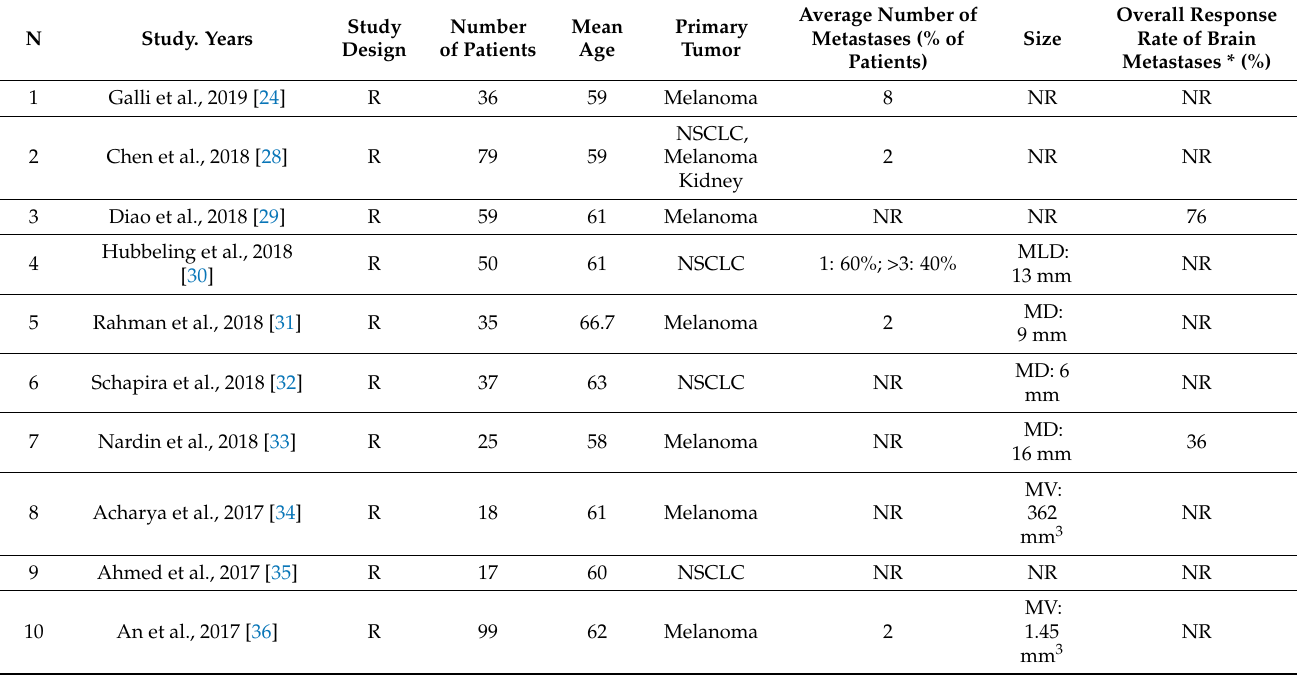
Figure 1. Study Attrition. Table 1. Studies selected for systematic review and meta-analysis.